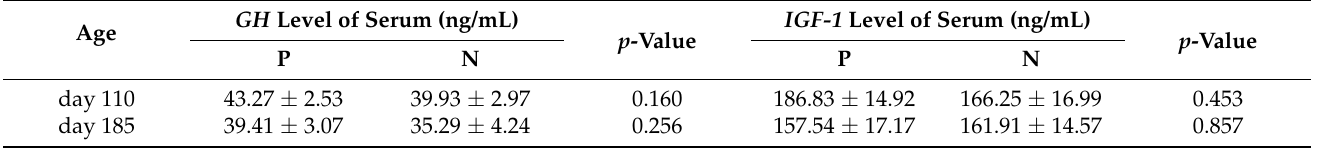
Table 3. The serum of the GH and IGF-1 levels in antibody-positive and antibody-negative pigs at different period.